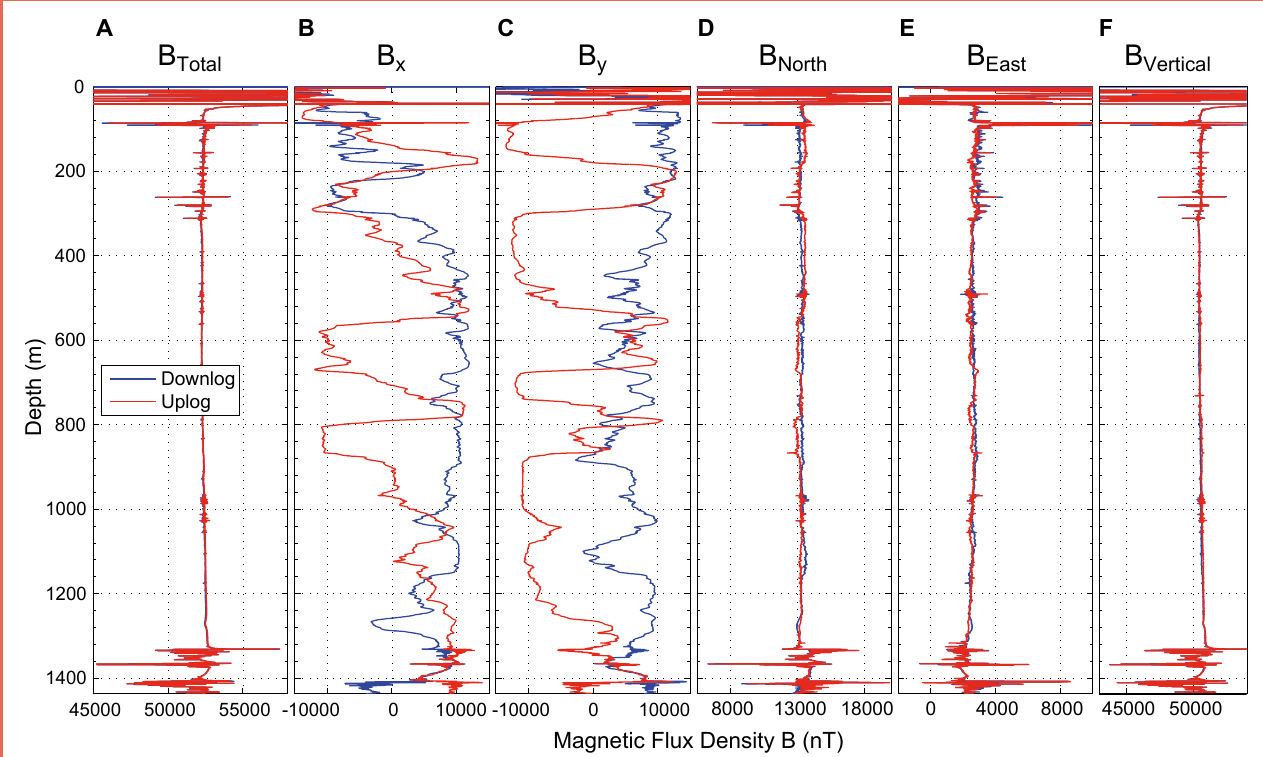
Figure 3. [A] Total magnetic flux density, [B and C] horizontal components before reorientation (internal tool coordinates xyz), [D–F] magnetic flux density after reorientation with geographic coordinates North, East,